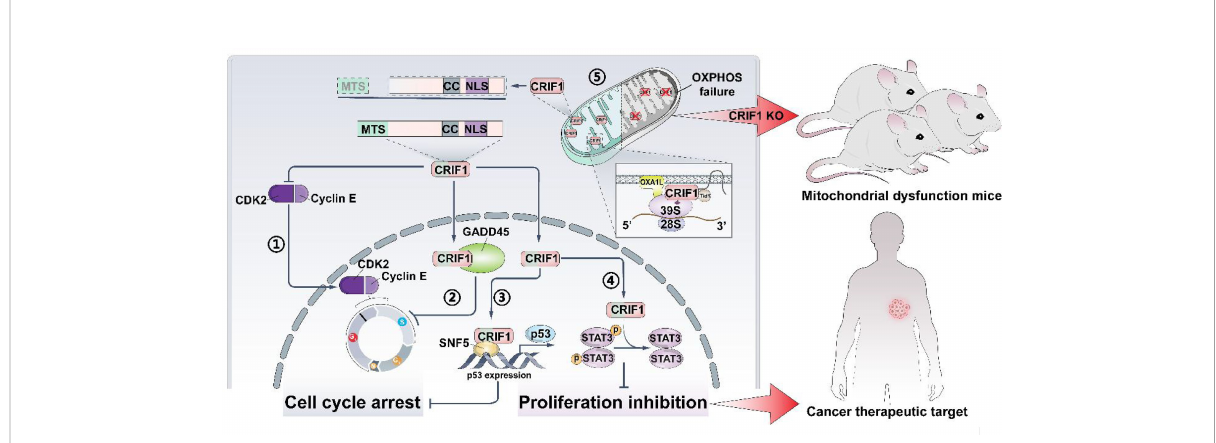
FIGURE 1 CRIF1 regulates cell cycle, cell proliferation, and OXPHOS capacity. It could be a cancer therapeutic target, and knocking down CRIF1 is an effective way to establish mitochondrial dysfunction in mice. CRIF1 binds to CDK2 and inhibits its activity ① . CRIF1 binds to Gadd45 family proteins and